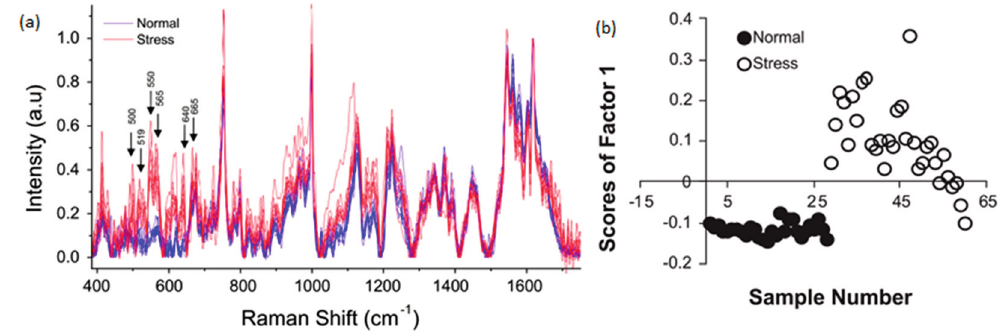
Figure 10. ( a ) Raman spectra from 10 normal cells and 10 cells exposed to oxidative stress. The variations between each spectra illustrate the cell-to-cell variation. Nonetheless, despite broadly similar Raman spectra; a PCA shown in ( b ) clearly differentiates between the stressed and unstressed cells [68] (With permission from Elsevier).